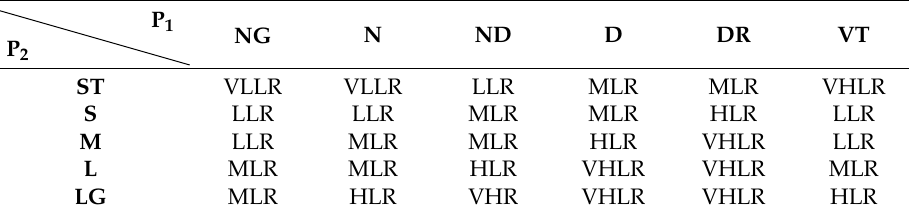
Table 2. Rule designed for fuzzy inference system (FIS)_1.